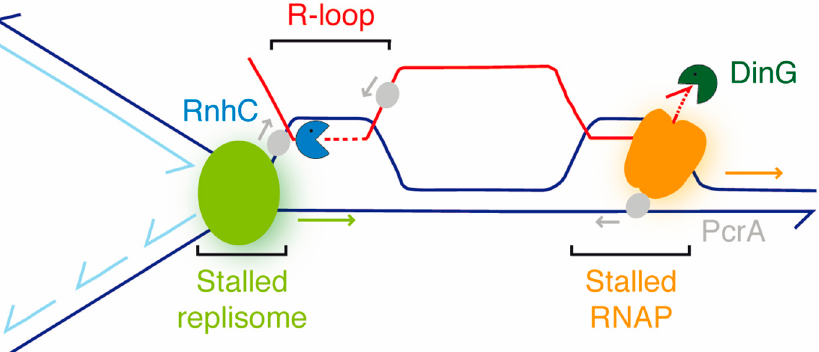
Figure 7. Accessory RNAP modulators (nucleases [RnhC, DinG] and a DNA helicase [PcrA]) aid in the resolution of RTCs. In a co-directional model, the RNAP (orange) stalls at a bulky lesion and impedes DNAP (light green) progression, and an R-loop is formed at the RTC. PcrA (gray) translocating in the non-template strand in the 3 ′ → 5 ′ direction interacts with the RNAP and backtracks it, with DinG (dark green) degrading the exposed 3 ′ -end of the mRNA to facilitate transcription re-initiation if the lesions were removed. RnhC (blue), upon interacting with the RNAP, cleaves the RNA at the R-loop, and then PcrA unwinds it from the DNA-RNA hybrid. The arrows denote the direction of the indicated enzyme.